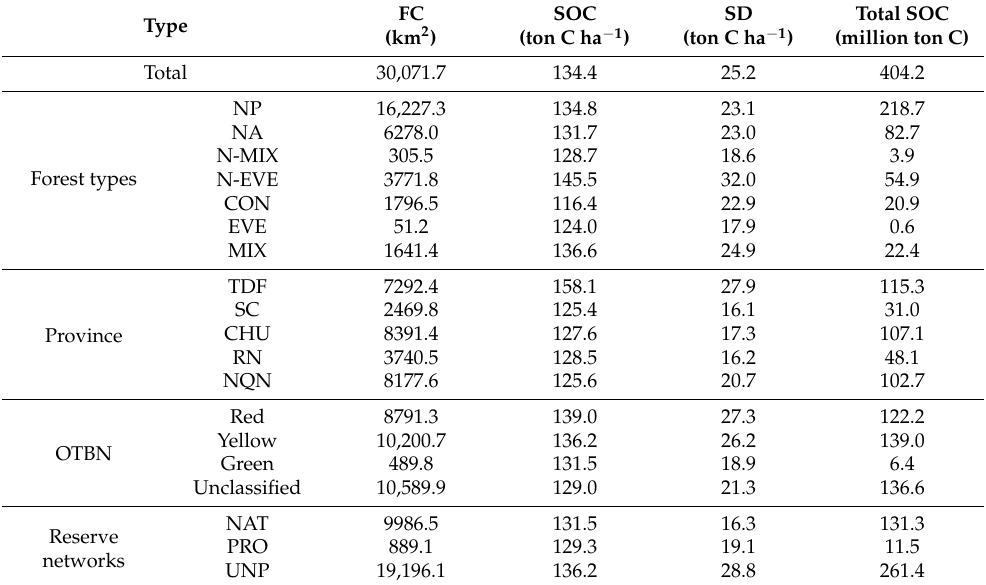
Table 3. Forest cover (FC, km 2 ), soil organic carbon content (SOC, ton C ha − 1 ) and standard deviation (SD, ton C ha − 1 ) to calculate the total C stock of Patagonian forests (million ton C), classified by forest types (see Table 1), provinces (TDF = Tierra del Fuego, SC = Santa Cruz, CHU = Chubut, RN = R í o Negro, NQN = Neuqu é n), protection status according to national law 26.331/07 (OTBN), and reserve networks (NAT = National Parks, PRO = Provincial Reserves, UNP = Unprotected). FC SOC Type (km 2 ) (ton C ha − 1